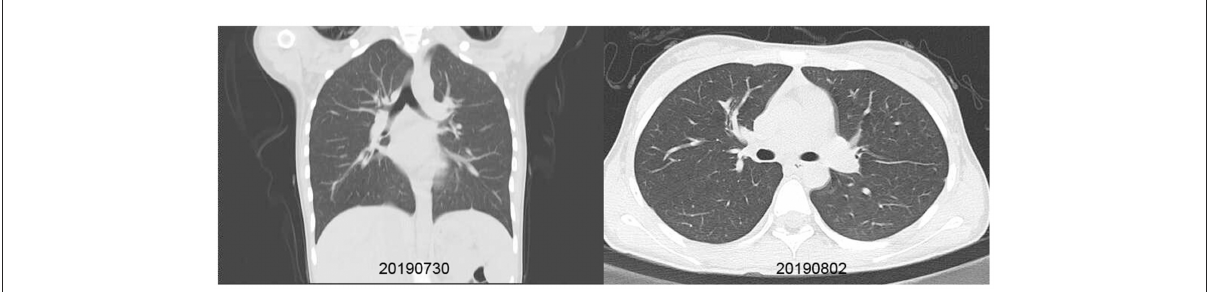
FIGURE3 Chest X-ray and CT scan taken for a 13-year-old girl with HCoV-229E and adenovirus coinfection-induced fever on July 27, 2019. Chest CT scan and chest X-ray indicated slight thickening of the wall of the anterior and posterior segments of the right upper lobe, a slightly narrower lumen, and slight inflammation of the lower right lung. The bilateral hilum was normal, and no pleural effusion was observed. No obvious swollen lymph node shadow was found in the mediastinum. (A) Left, Chest X-ray taken on July 30, 2019. (B) Right, Chest CT scan taken on August 2, 2019.